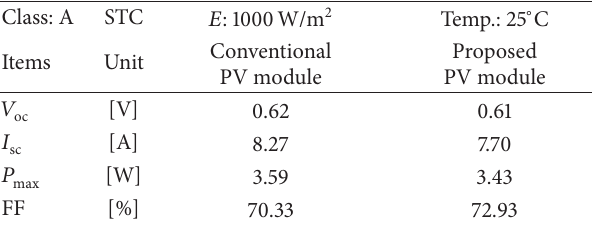
Table 3: Results of maximum power determination test for PV